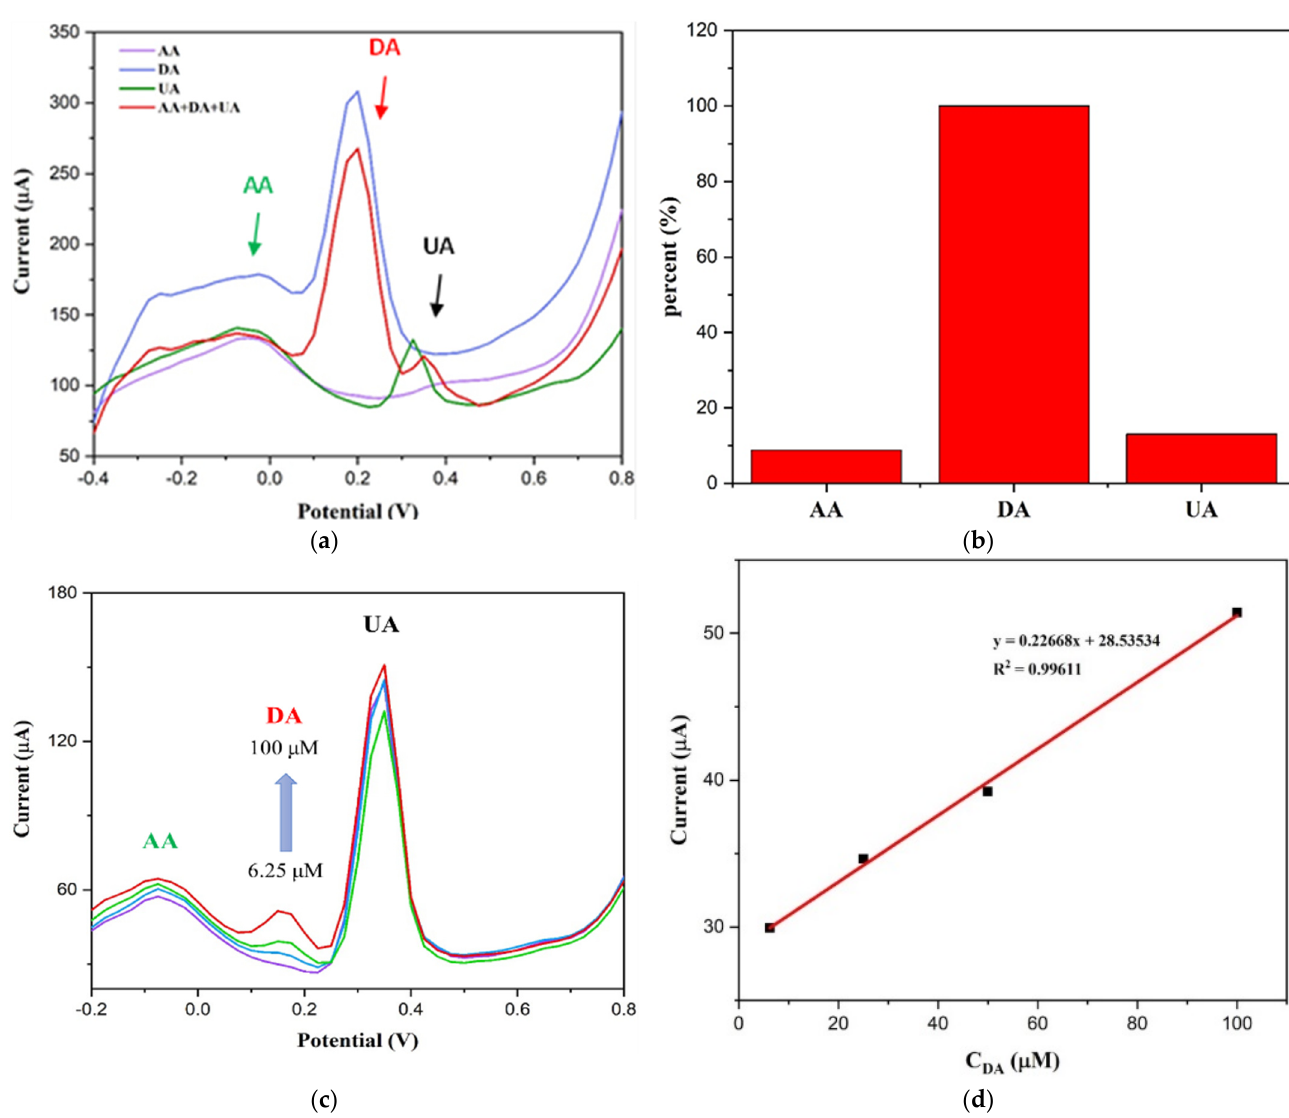
Figure 10. ( a ) DPV curves for selective detection. ( b ) Interfering effect of ascorbic acid and uric acid. ( c ) Standard addition of the DA concentration from 6.25 μ M to 100 μ M under 400 μ M AA and 1000 μ M UA. ( d ) The calibration curve of DPV peak current versus various 6.25 μ M to 100 μ M DA concentration and under 400 μ M AA and 1000 μ M UA.